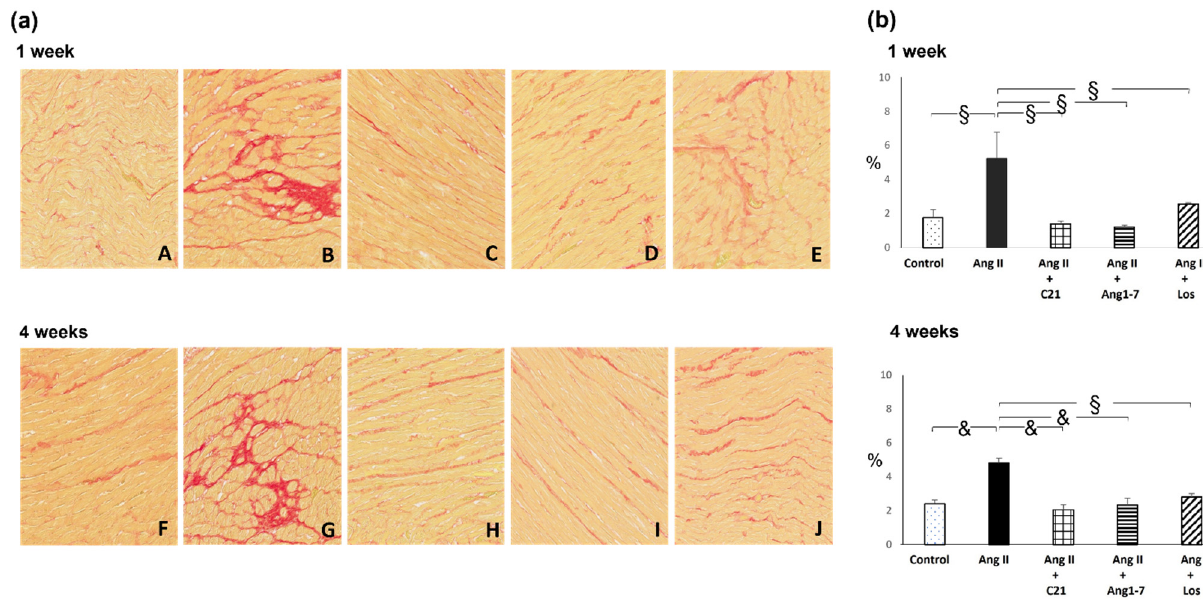
Figure 1. Myocardial interstitial fibrosis. Effects of C21 and Ang 1-7 administration on myocardial interstitial fibrosis in Ang II treated rats for 1 and 4 weeks of treatment. ( a ). Representative photomicrographs of interstitial fibrosis in control (A,F), Ang II (B,G), Ang II + C21 (C,H), Ang II + Ang 1-7 (D,I) and Ang II + Los (E,J) treated rats ( × 20 magnification) after 1 and 4 weeks of treatment. ( b ). Quantification of interstitial fibrosis in the different groups of rats. Data are means ± SEM. &: p < 0.01. §: p < 0.0001.